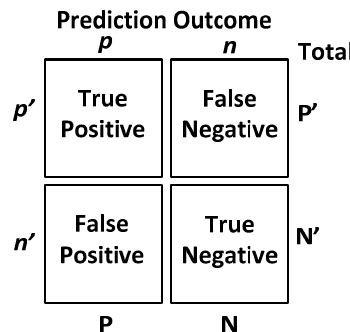
Figure 13. The definition of the confusion matrix [20], which is a tool for analyzing how well a classifier can recognize input features of different classes by tabulating the classification results correctly/incorrectly as predicted by the classification model.